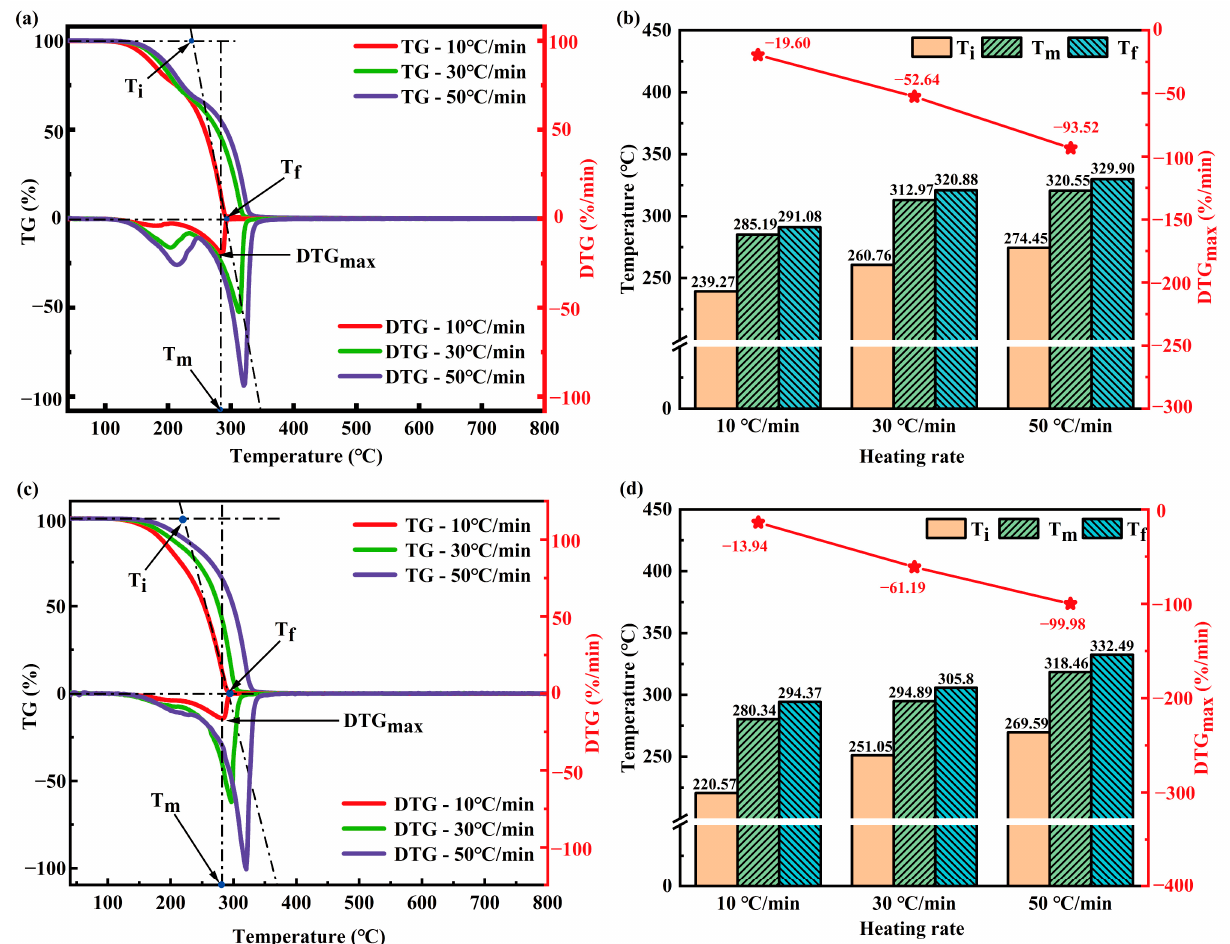
Figure 3. ( a , c ) TG and DTG curves of WCO-Biodiesel and WCO-Biodiesel-CS blends at heating rates of 10, 30 and 50 °C/min under the influence of CS, ( b , d ) pyrolysis characteristic parameters. In Figure 3. (b,d), T i , T m , T f and DTG max are the four characteristic parameters of WCO-